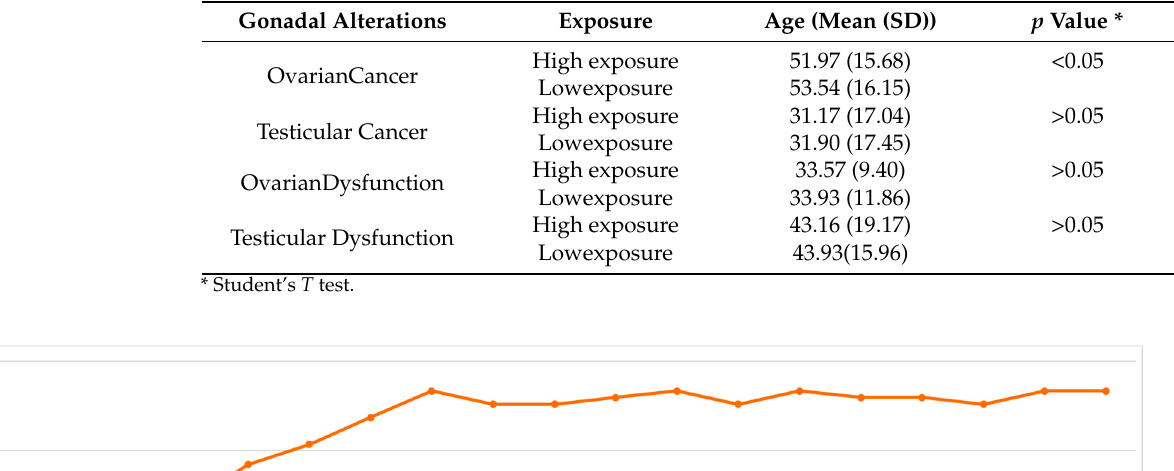
Table 1. Comparison of the mean age by the geographical areas studied (high and low pesticide expo- sure).